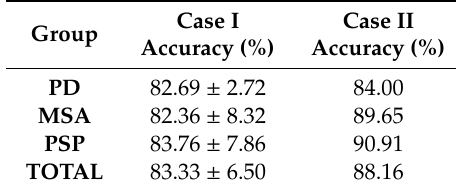
Figure 8. Dependency of: ( a ) calculated scores and the α av feature; ( b ) calculated scores the and f feature. Grey circles mark samples that are assigned to the C 1 cluster (“wider and slower” performance), whereas black crosses correspond to members of the cluster C 2 (“narrower and faster” performance).